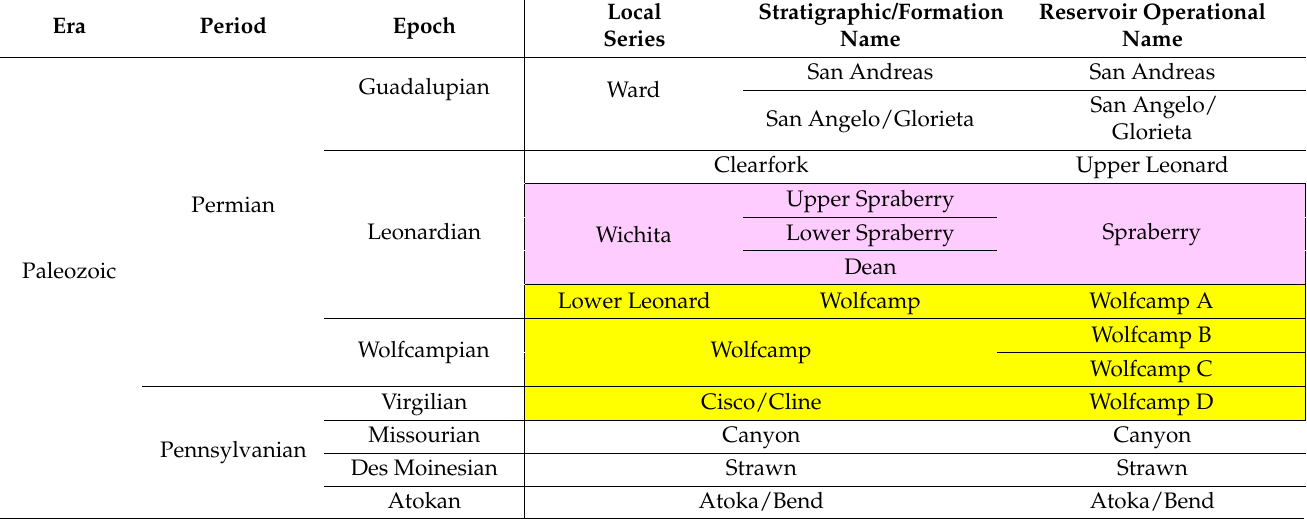
Table 1. Stratigraphic description for a subset of the Midland Basin, Texas. The producing reservoirs of interest to this study are highlighted (Spraberry in pink and Wolfcamp in yellow). This figure was generated from collective content compiled from lithostratigraphic interpretations of the Permian Basin from several literature sources